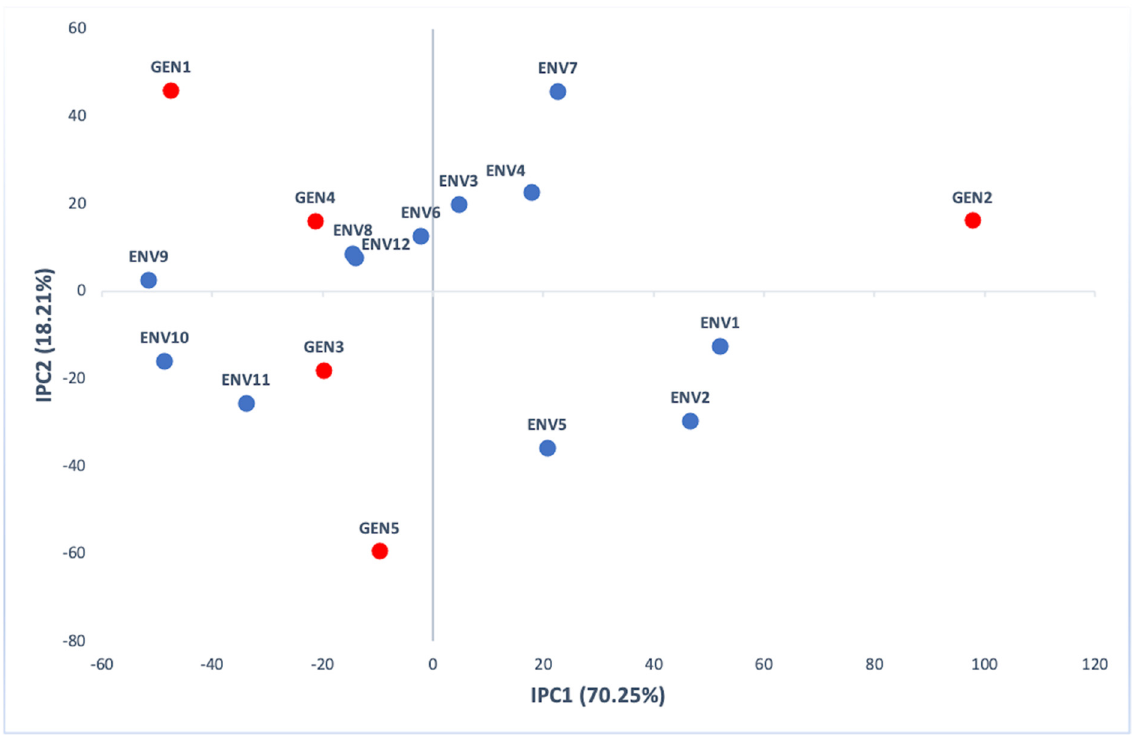
Figure 2. AMMI biplot presenting the second interaction principal components (IPC2) versus the first interaction principal components (IPC1) scores for grain yield (kg/ha) of five genotypes evaluated in 12 environments. Giannouli was the location with the highest mean temperature during the cultivation period (March–September) for both years (22.2 and 22.4 °C in 2017 (ENV1) and 2018 (ENV2), respectively). The lowest mean temperature was recorded at Kalamonas for both years (19.7 and 20.4 °C in 2017 (ENV9) and 2018 (ENV10), respectively). At Koutso